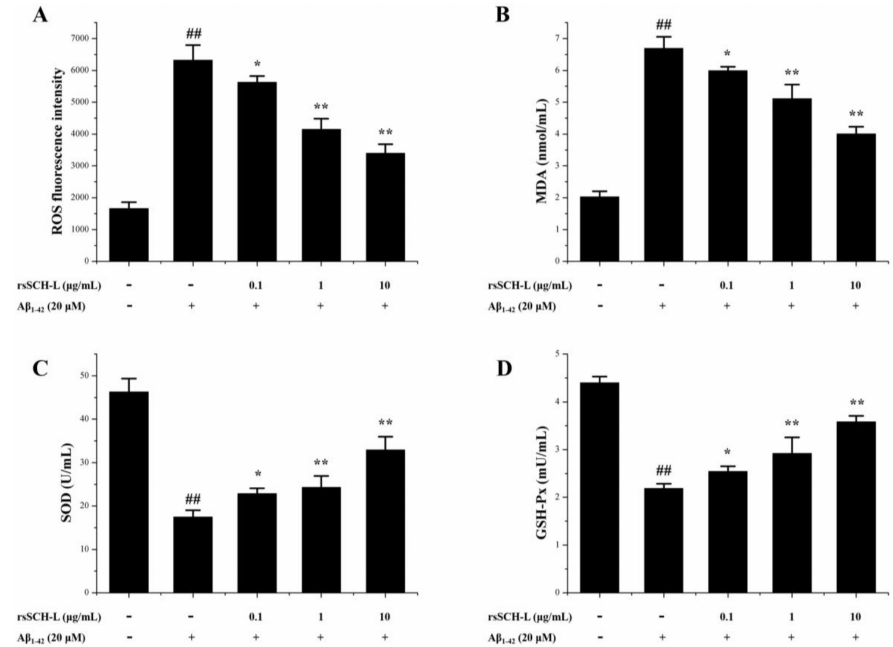
Figure 4. Effects of rsSCH-L in A β 1-42 -induced neuronal cells on the levels of ROS and MDA and activity of SOD and GSH-Px release. ( A ) Effect of rsSCH-L on the ROS level in neuronal cells. ( n = 3); ( B ) Effect of rsSCH-L on the MDA level in neuronal cells. ( n = 3); ( C ) Effect of rsSCH-L on the SOD activity in neuronal cells. ( n = 3); ( D ) Effect of rsSCH-L on the GSH-Px activity in neuronal cells. ( n = 3) ## p < 0.01 vs. control group, * p < 0.05, ** p < 0.01 vs. A β 1-42 group.